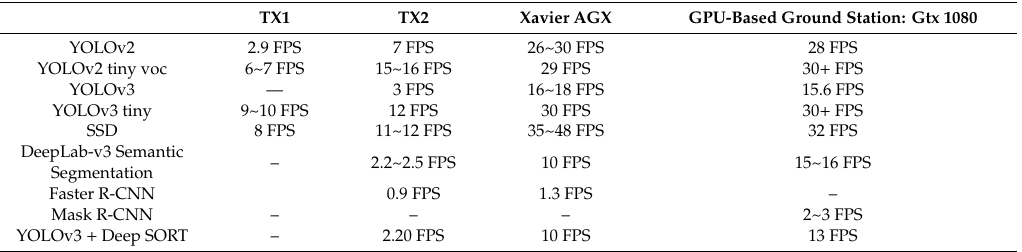
Table 5. Performance comparison between Jetson modules and GTX 1080 used for target detection and